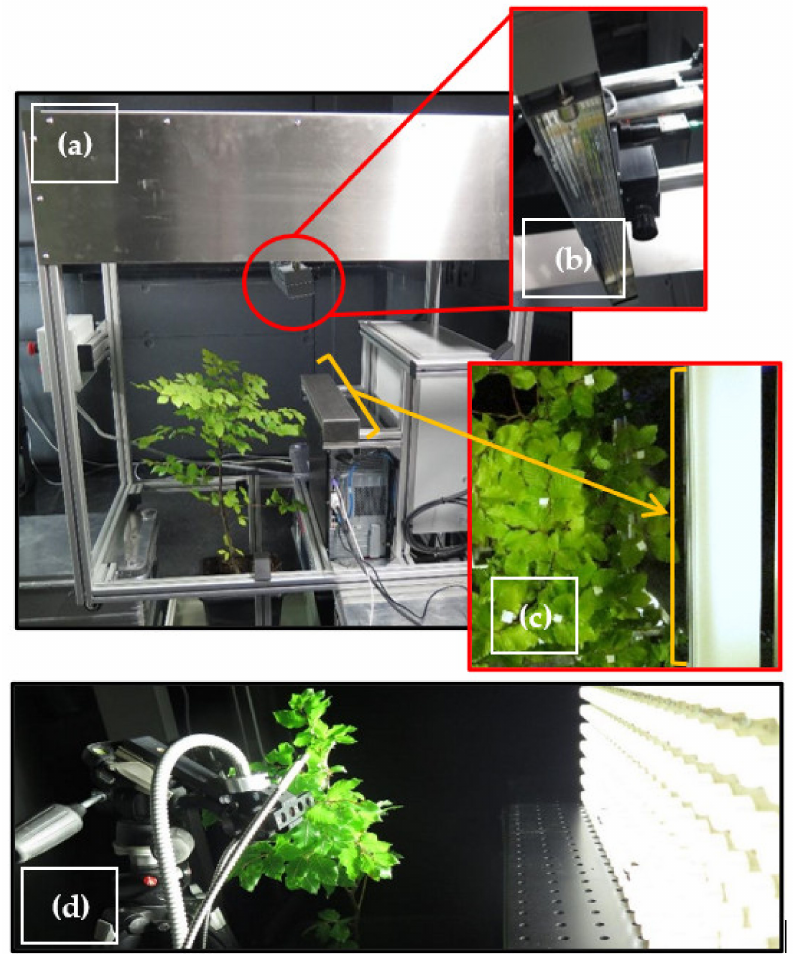
Figure 1. Instrument experimental set up: ( a ) frame supporting the hyperspectral camera mounted on the scanning mechanism with the tungsten-halogen lamp illumination, the control system, and the horizontal white reference panel (covered by the protection plate); ( b ) detail of the hyperspectral scanner with the halogen lamp; ( c ) Nadir view of the set-up showing plants with small white reference panels on the leaves, and the horizontal white reference panel; ( d ) FluoWat leaf clip set-up in front of the white LED panel, using of a short-pass filter to filter out incoming radiance above 650